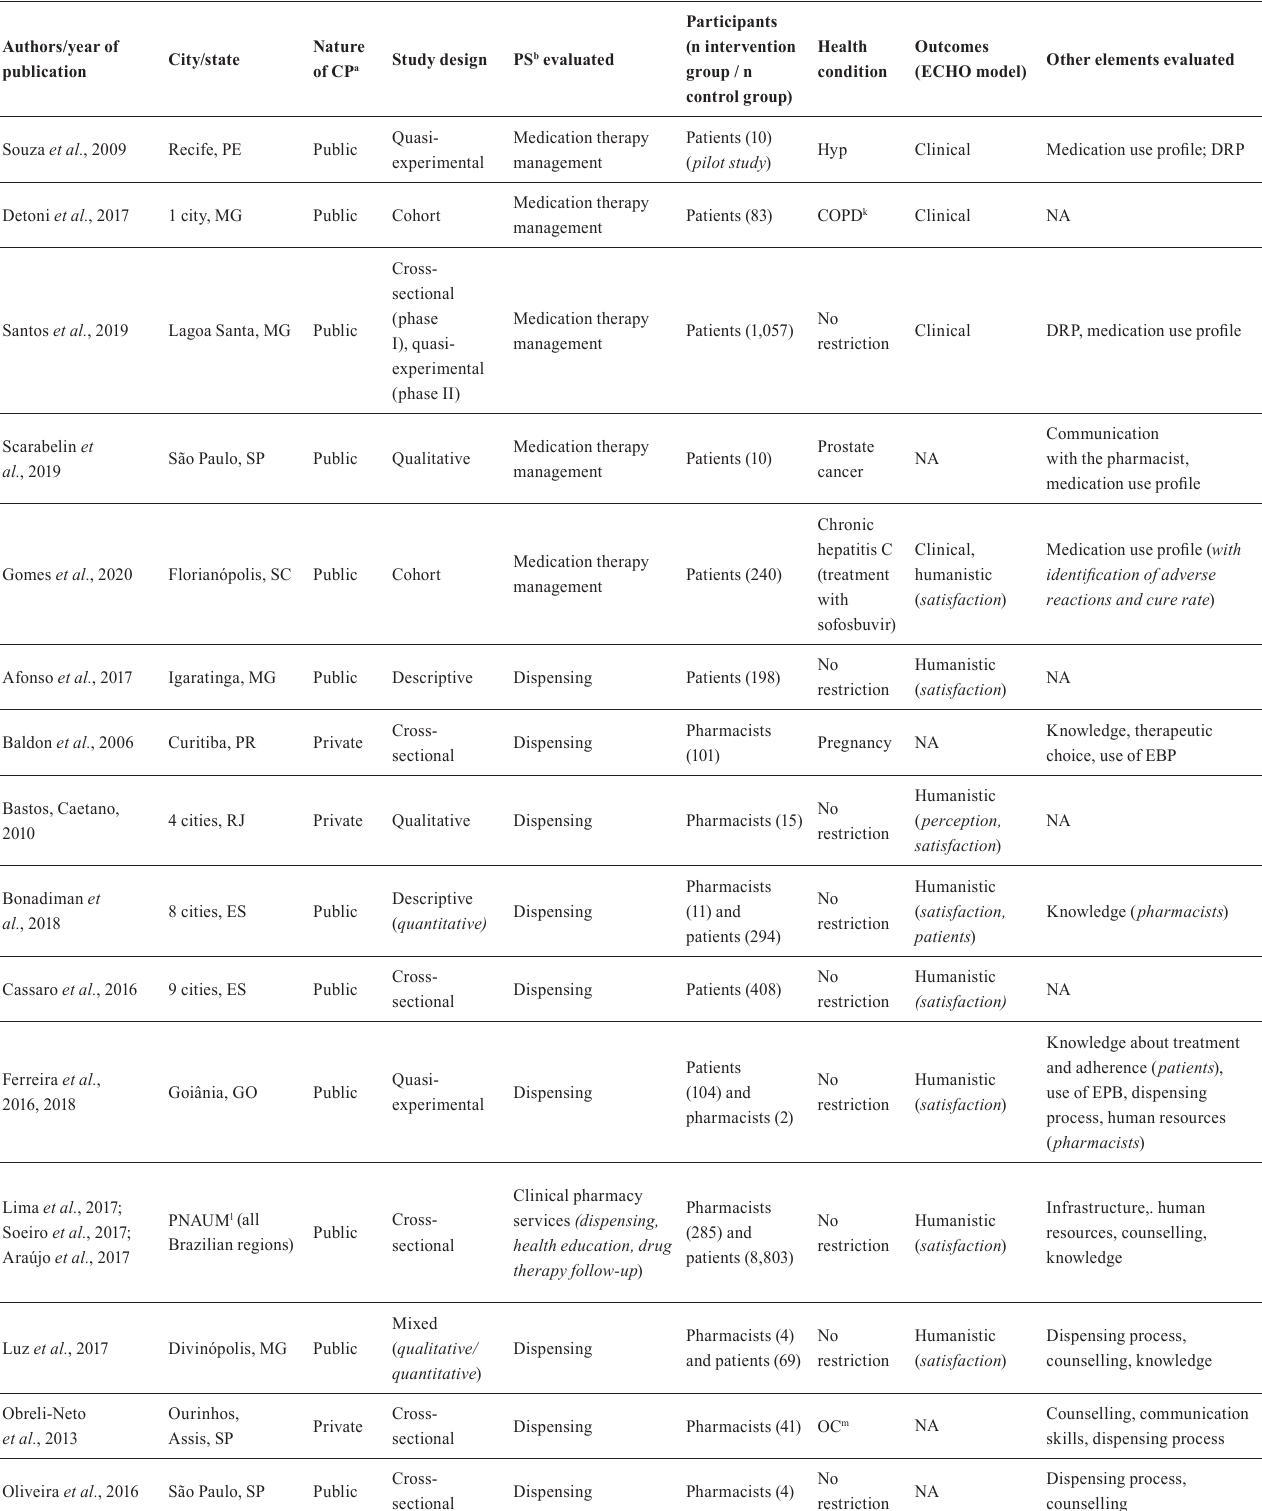
TABLE I - S ummary of the data from studies included in the scoping